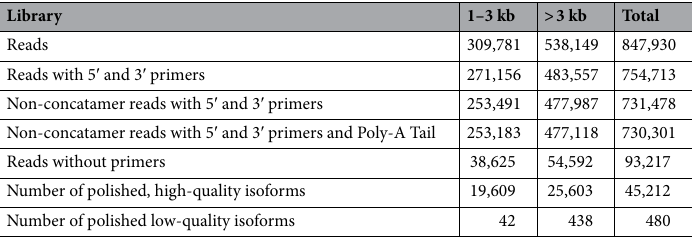
Table 1. Classification and cluster summary of PacBio SMRT Iso-seq data for faba